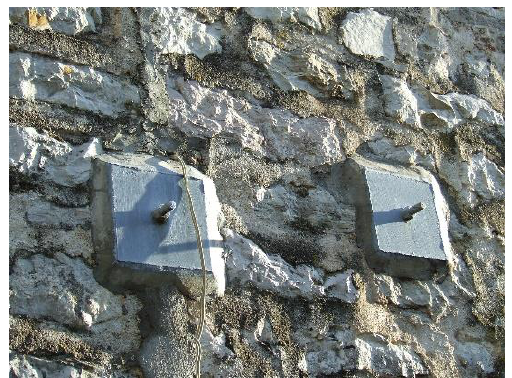
Figure 24. At their ends, the rods were anchored to the 10 mm thick steel plates.